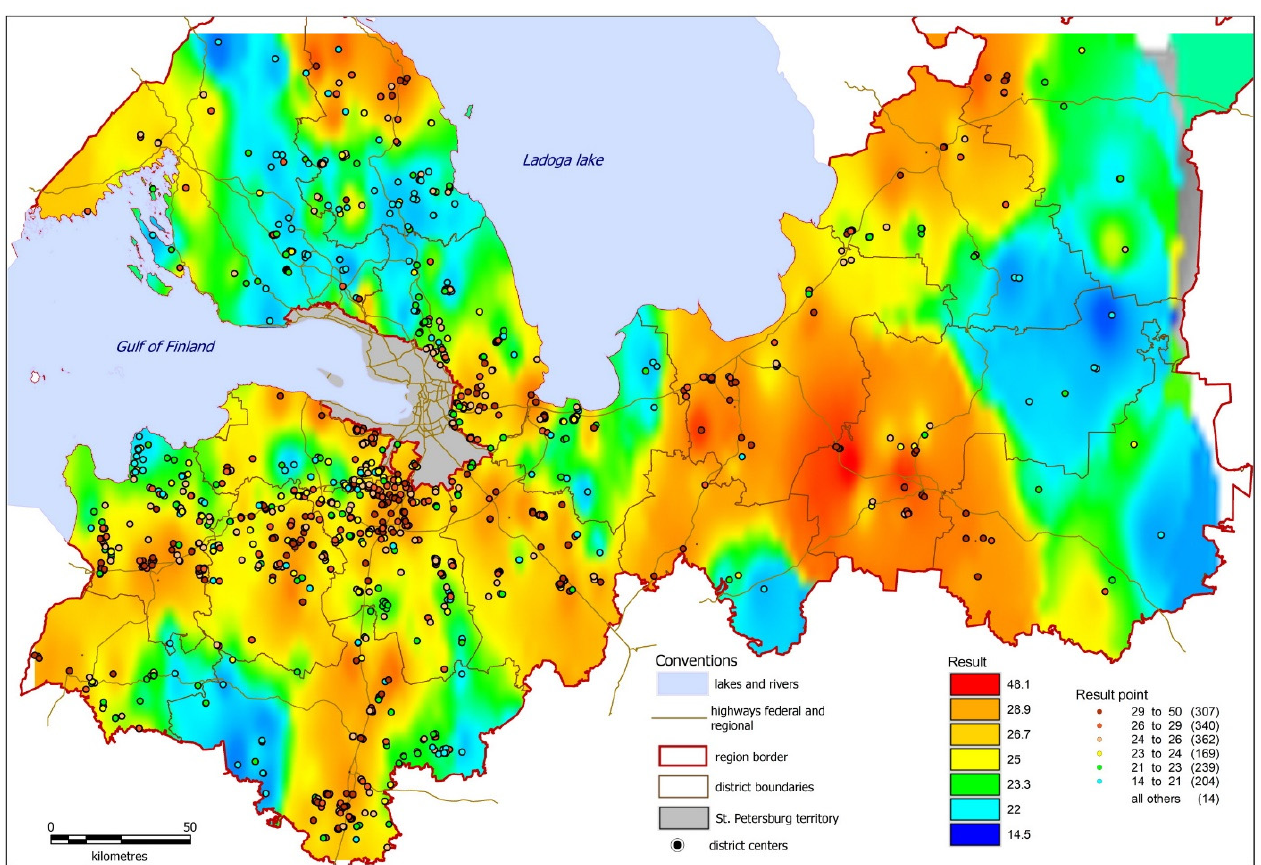
Figure 3. Map of the cost of 1 sqm of land plot in the Leningrad region, assuming the location of agricultural production.